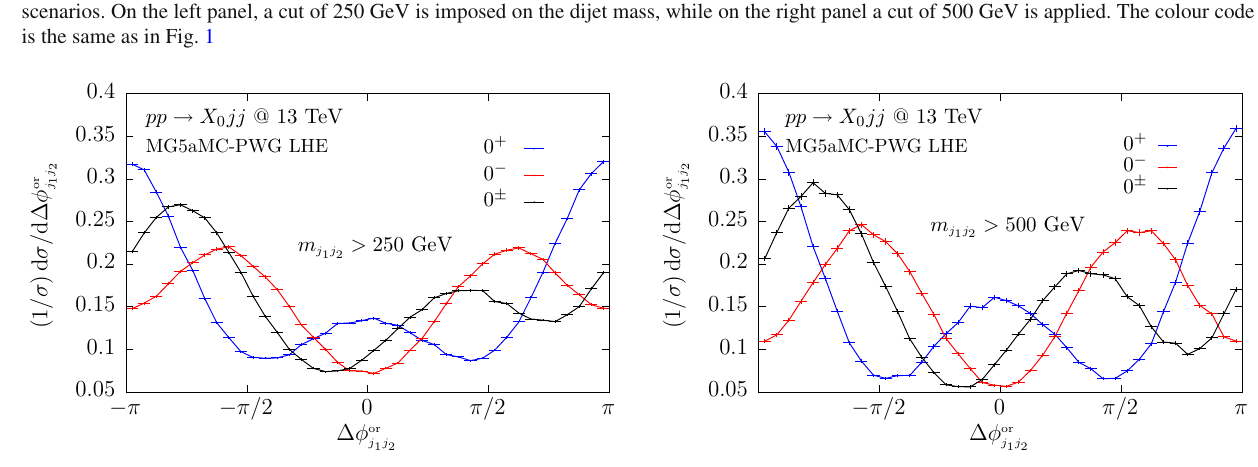
Fig. 8 Normalised differential cross section as a function of the ori- ented azimuthal separation of the two leading jets, defined in Eq. (3.12), forthethreeCPscenarios.Ontheleftpanel,acutof250GeVisimposed